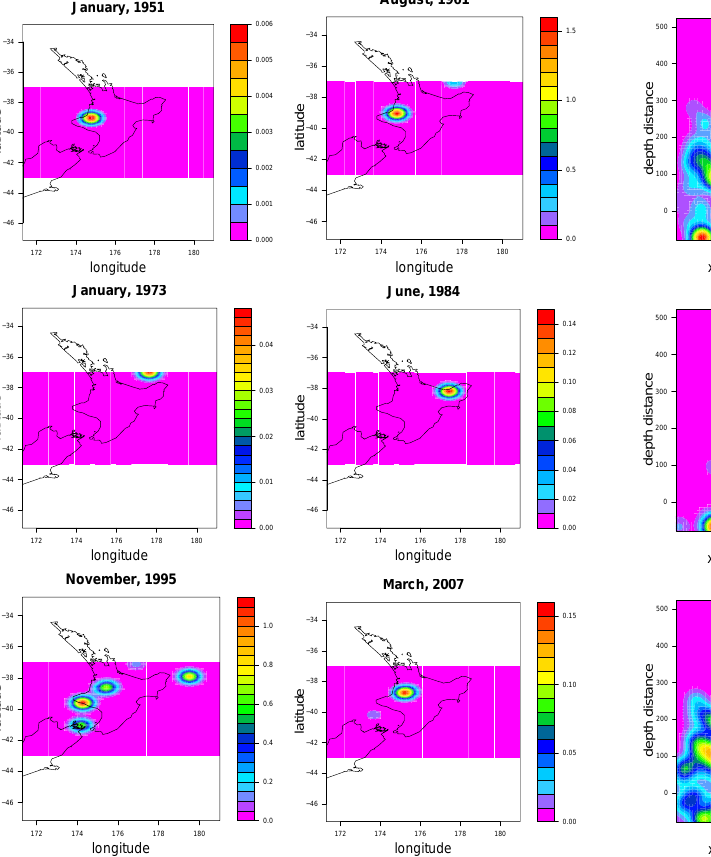
Fig. 8. Space-time-magnitude smoothed conditional intensity func- tion for M = 6 . 5 around a fixed point at six different times.